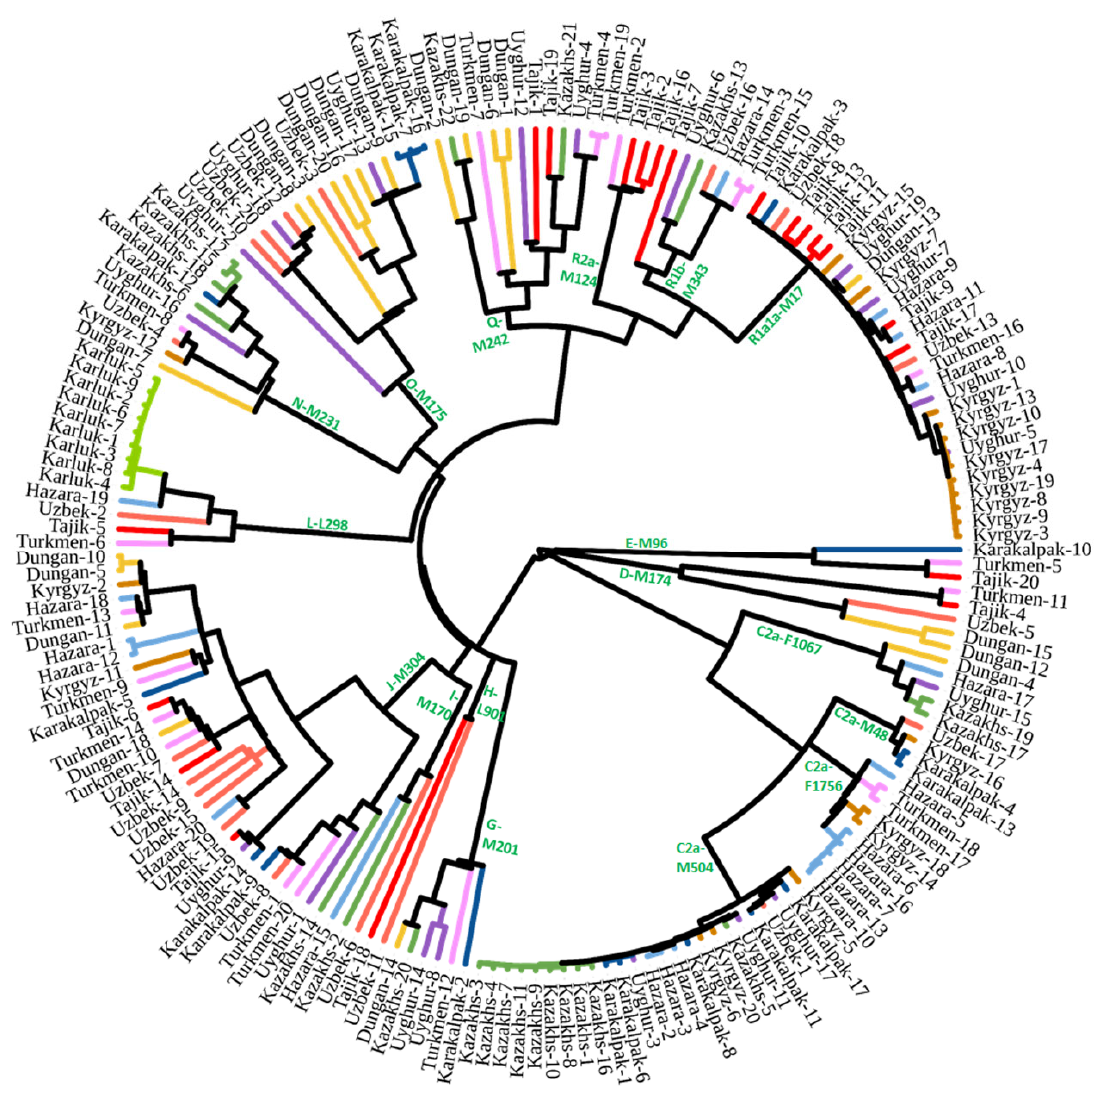
Figure 2. Revised phylogenetic tree based on Y ‐ chromosomes of populations in Central Asia.